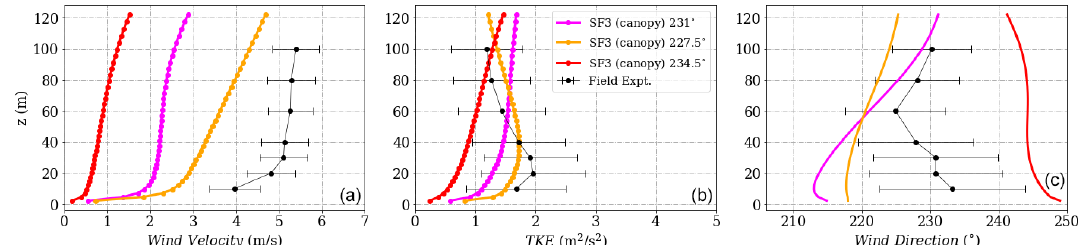
Figure D6. (a) Wind velocity magnitude, (b) wind direction and (c) turbulent kinetic energy at Tower 29 (tse13) for the SF3 (canopy) model.